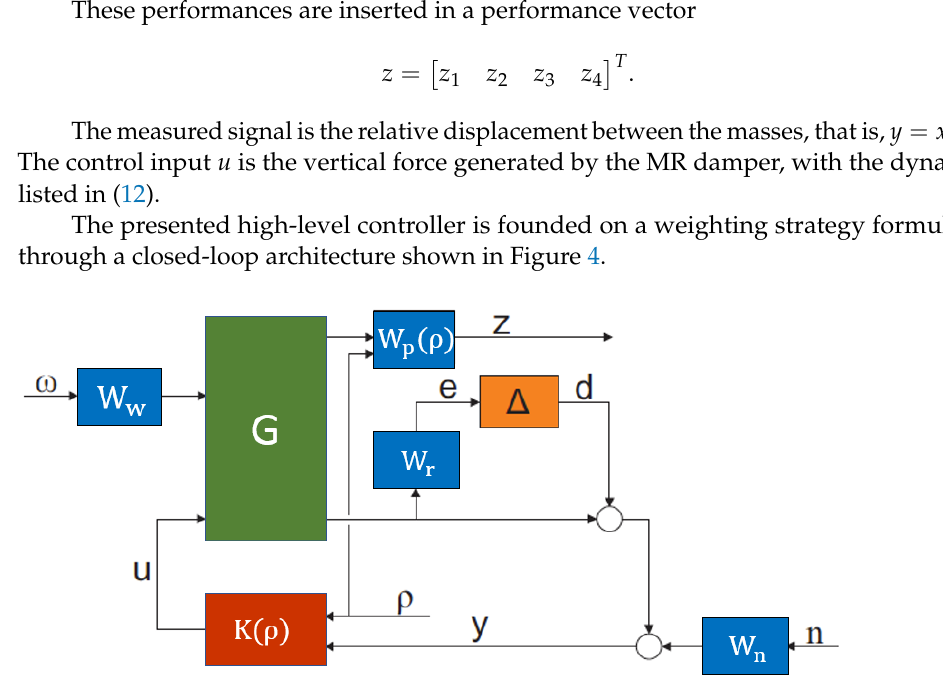
Figure 4. Closed-loop interconnection